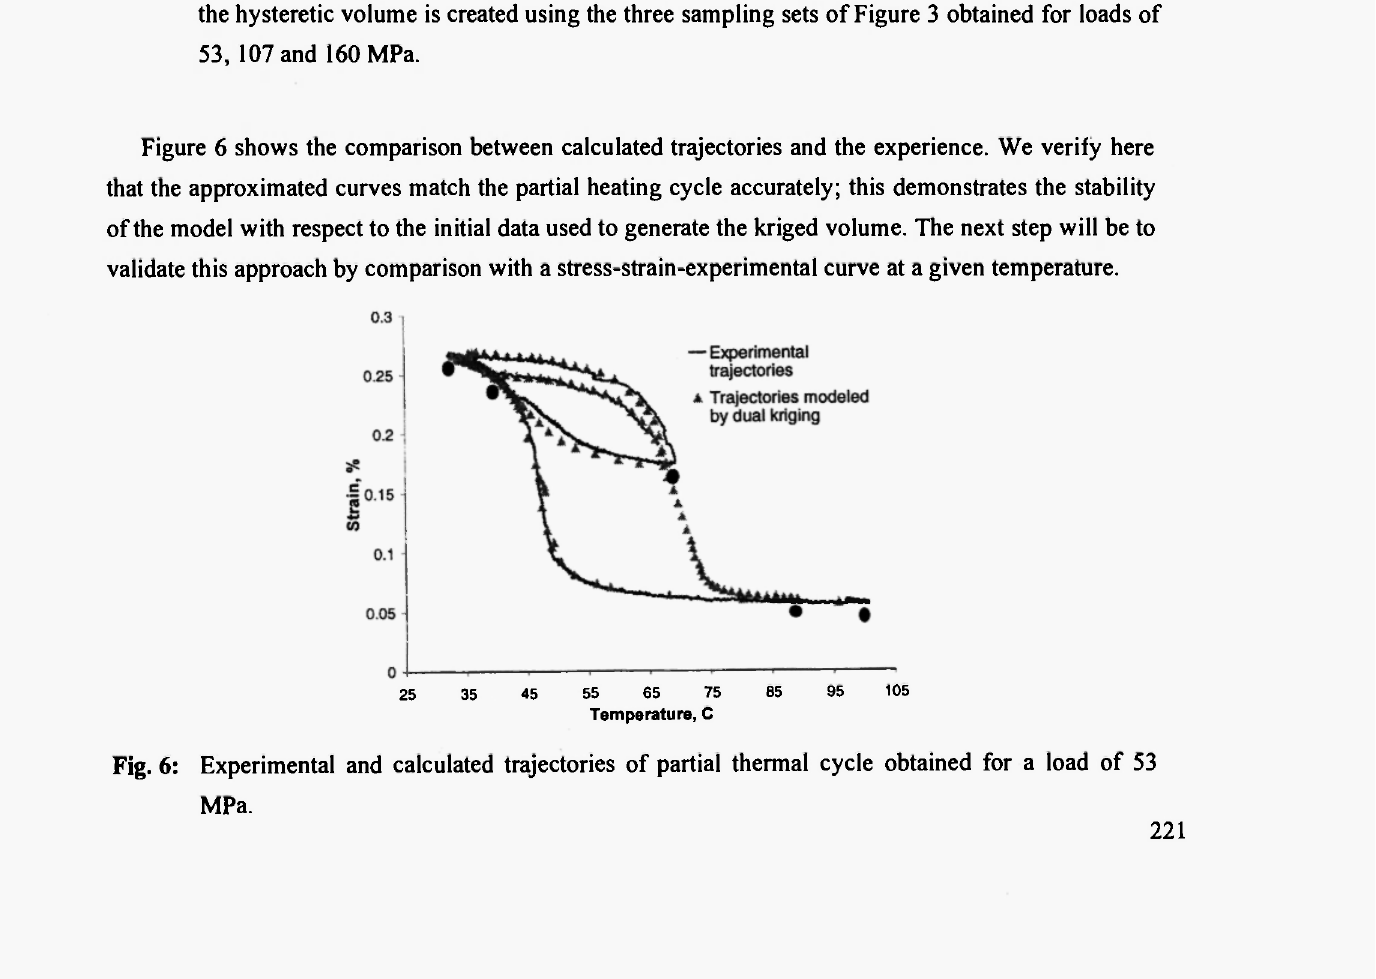
Fig. 6: Experimental and calculated trajectories of partial thermal cycle obtained for a load of 53